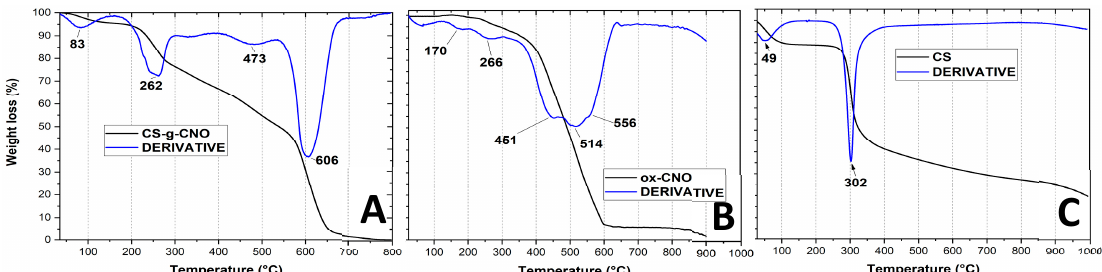
Figure 5. Thermogravimetric analysis of ( A ) chitosan-grafted carbon nano onion (CS-g-CNO), ( B ) oxidized carbon nano onion (ox-CNO), and ( C ) chitosan CS.